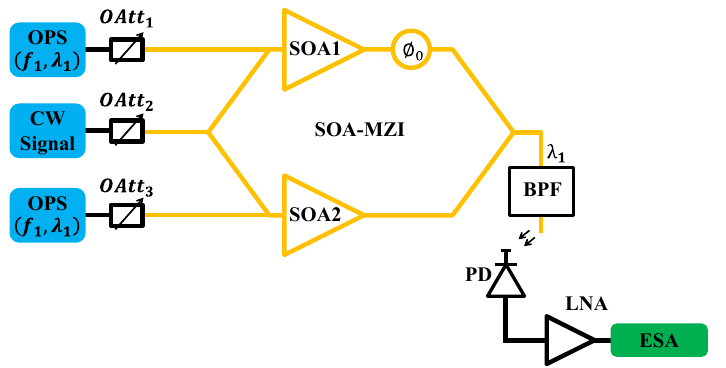
Figure 2. Experimental Setup for OPS response at the SOA-MZI output. OPS: Optical Pulse Source, OAtt : Optical Attenuator, ESA: Electrical Spectrum Analyzer, CW: Continuous Wave, PD: Photodiode, and LNA: Low Noise Ampli fi er.